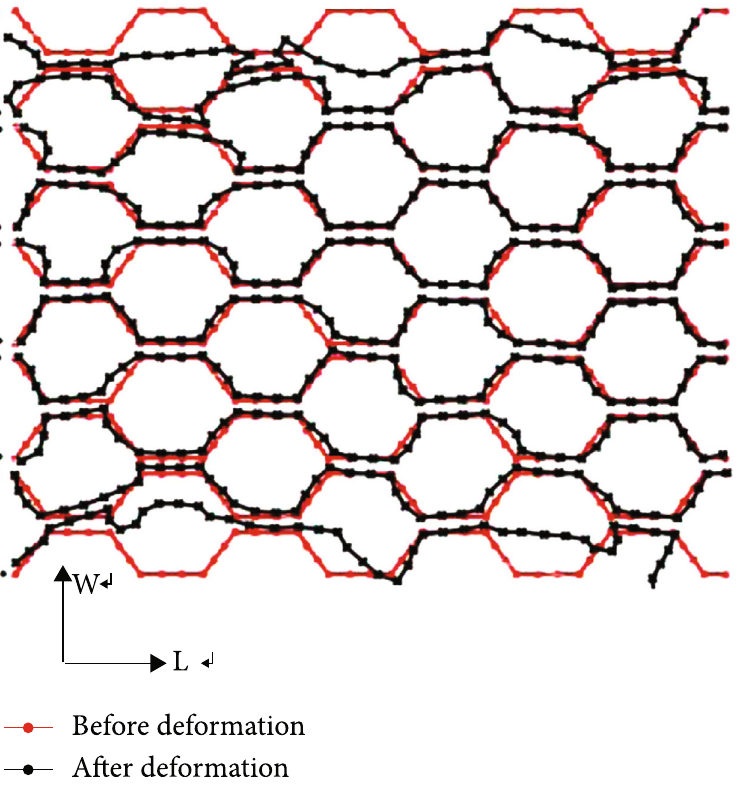
Figure 11: The structure of the square honeycomb before and after the deformation of the upper surface when the di ff erent faces are